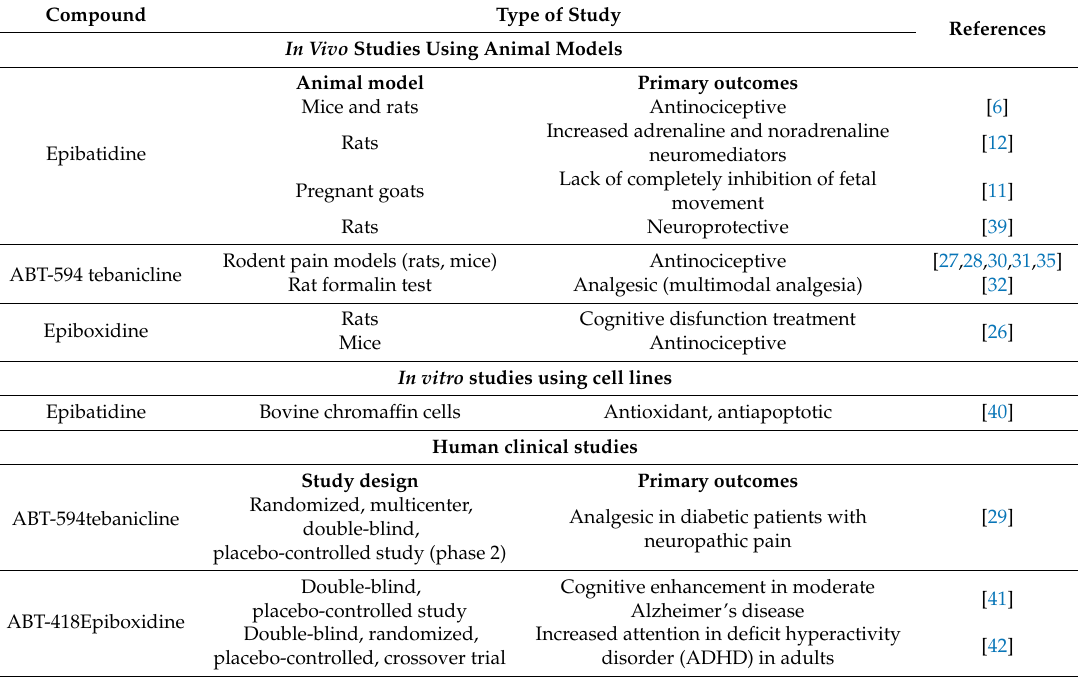
Table 1. Pharmacological studies of epibatidine and its synthetic